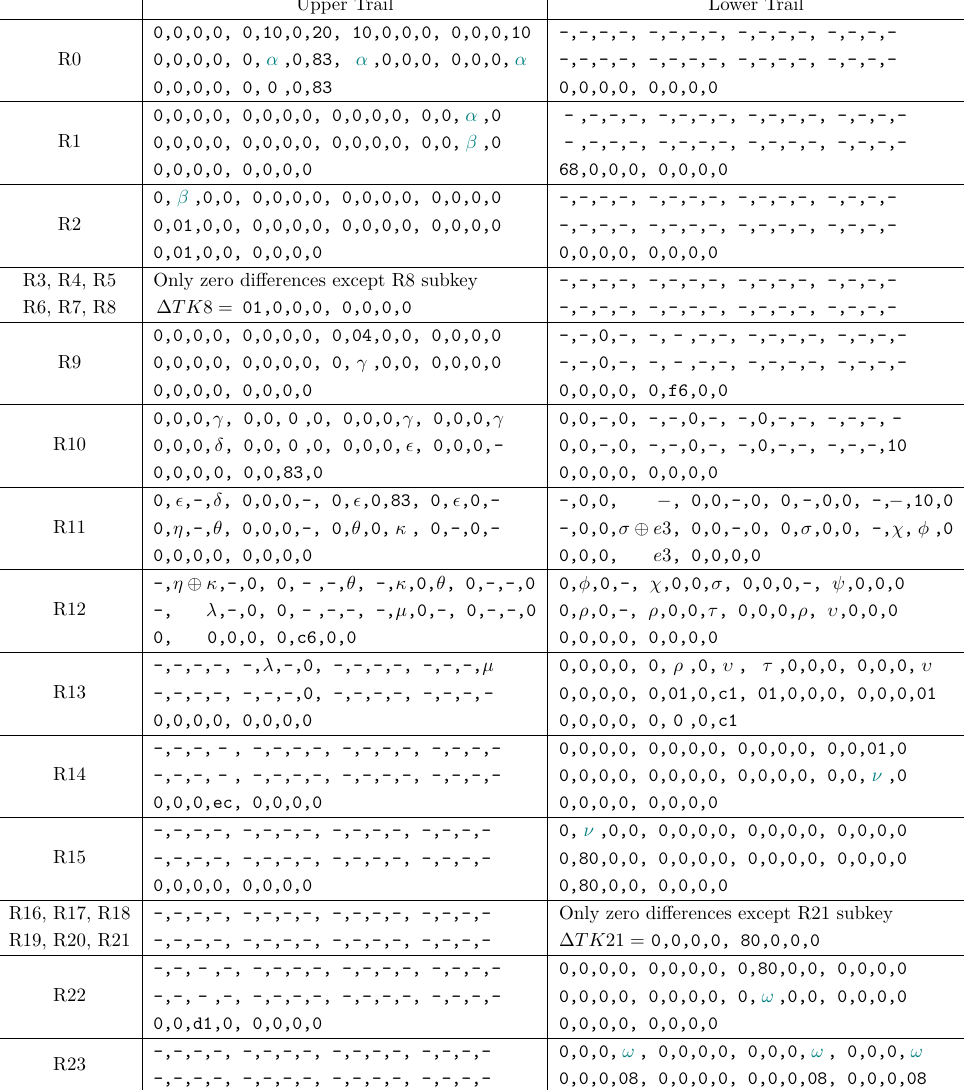
Table 4: Characteristic on 24 rounds of skinny -128-384. Values are represented in hexadecimal, greek letters are variables used in the sum, and dashes are unspecified